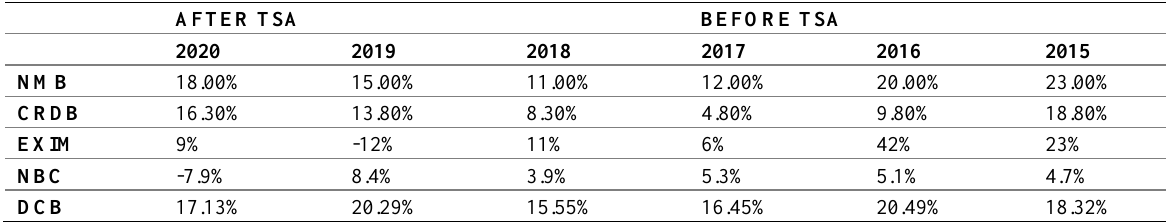
Table 6: Return on Equity